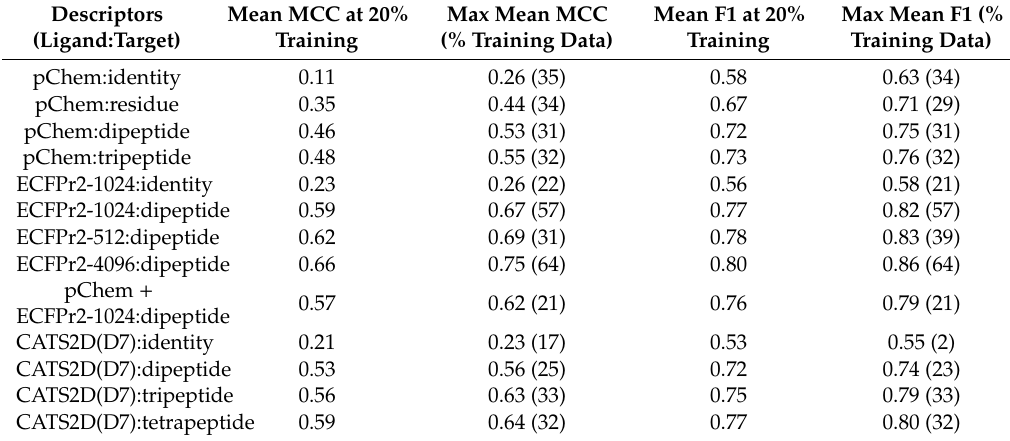
Table 2. MMP non-probe training, probe prediction performance by curiosity-type chemogenomic active learning. Contributions of overlapping target subsequences toward probe profile prediction are confirmed across multiple representations of compounds. Identification of the probe compound interactions is successful as early as 20%, as measured by F1 values. MCC di ff ers from F1 values by further factoring in model discrimination ability with respect to selectivity. In no case does learning the full training set contribute to improved external prediction